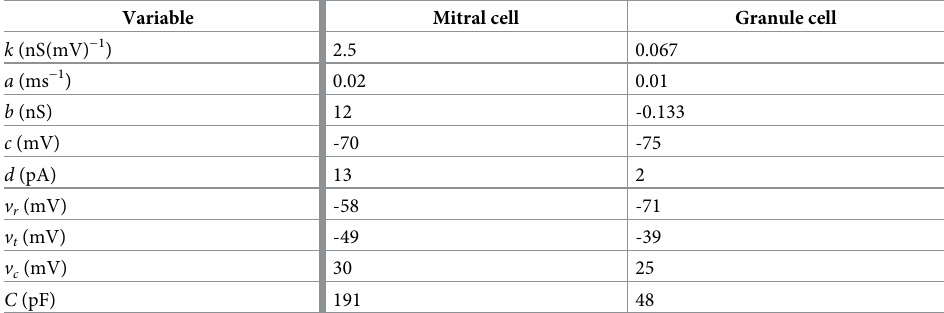
Table 1. Parameters for single cell internal